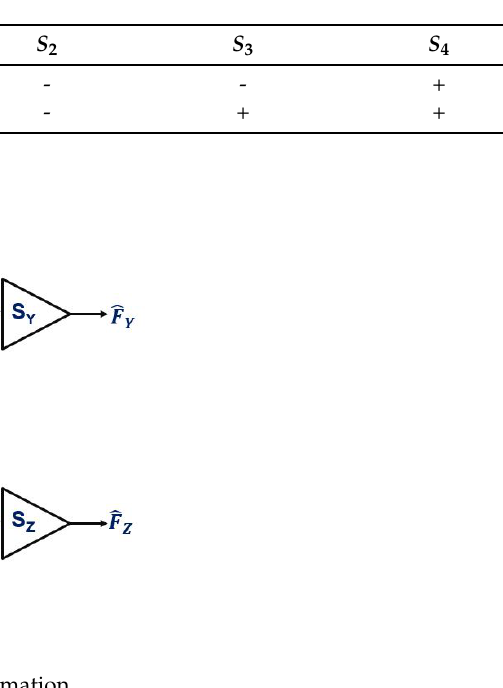
Table 1. External force influence with direction.